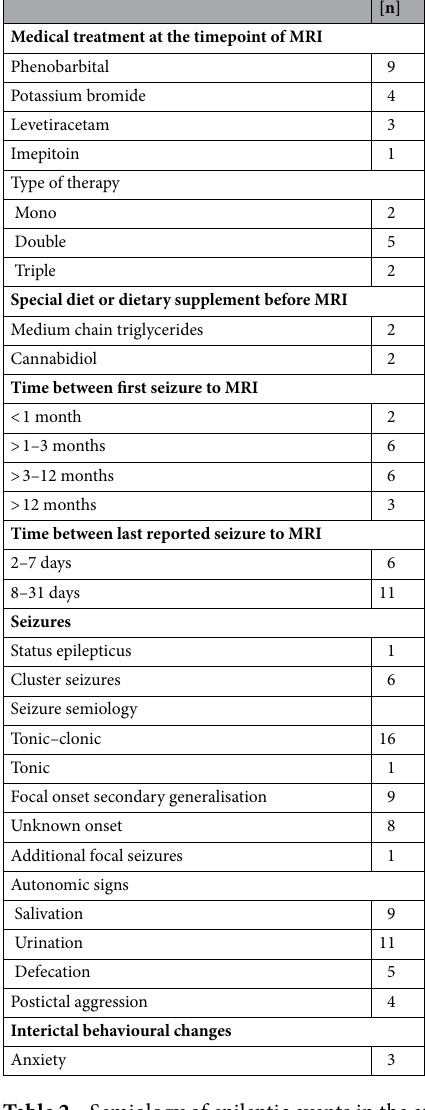
(Fig. 1B: RSN3: primary visual, RSN 4 and 5 higher order visual) and two networks were identified in areas cor- responding to the pericentral networks (Fig. 1C: RSN 6 and RSN 7: auditory). After dual regression analysis, no significant differences were detected in RSNs when comparing the differ- ent breeds, therefore excluding the effect of breed on RSNs and indicating that the observed networks can be compared across breeds. When comparing ICA between the population of epileptic dogs with controls (Fig. 2), a total of eight RSNs were identified and labelled as described above. Of those eight networks, one was identified as medial frontopa- rietal network (Fig. 2A: RSN 1 anterior DMN), one was identified as limbic-occipital network (Fig. 2A: RSN 2 posterior DMN) , three were identified in the occipital cortex (Fig. 2B: RSN3: primary visual, RSN 4 and RSN 5: higher order visual) and three were identified in areas corresponding to the pericentral networks (Fig. 2C: RSN 5 and RSN 6: auditory and RSN 7 somatosensory network). Statistical difference of large-scale networks between the epileptic dogs and the healthy controls was found at the rostral component of the DMN and the primary visual network, which showed increased connectivity in the epileptic group relative to healthy controls. In the two-sample t test the rostral component of the DMN showed a p-value of 0.00060 (Fig. 3) and the primary visual network a p-value of 0.0018 (taking in account the Bonferroni correction, p had to < 0.003125 for statistical significance). In the remaining six RSN, no statistical difference between epileptic and controls were found (Table 3).